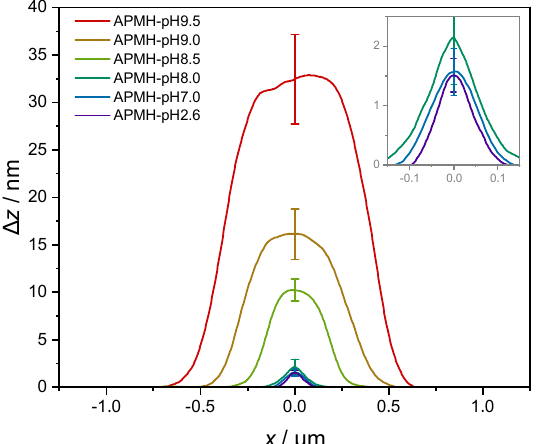
Figure 10. Average height profiles of poly(NIPAM- co -APMH) microgels, synthesized at different pH, extracted from Figure 9.